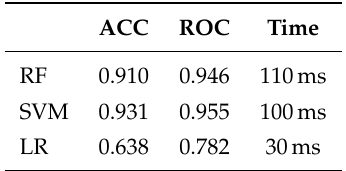
Table 1. Comparison of learning algorithms.